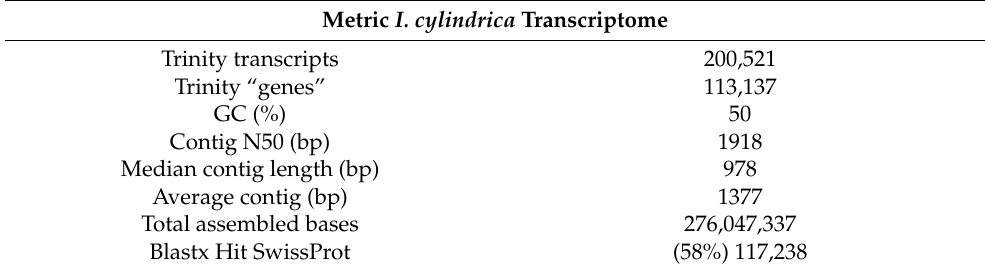
Table 1. De novo transcriptome assembly of Imperata cylindrica by